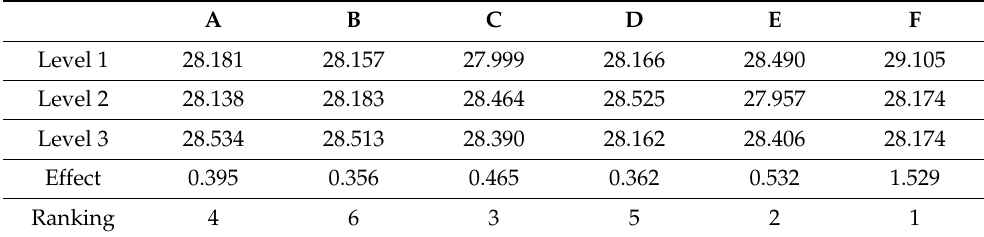
Table 12. The response table of the elongation at